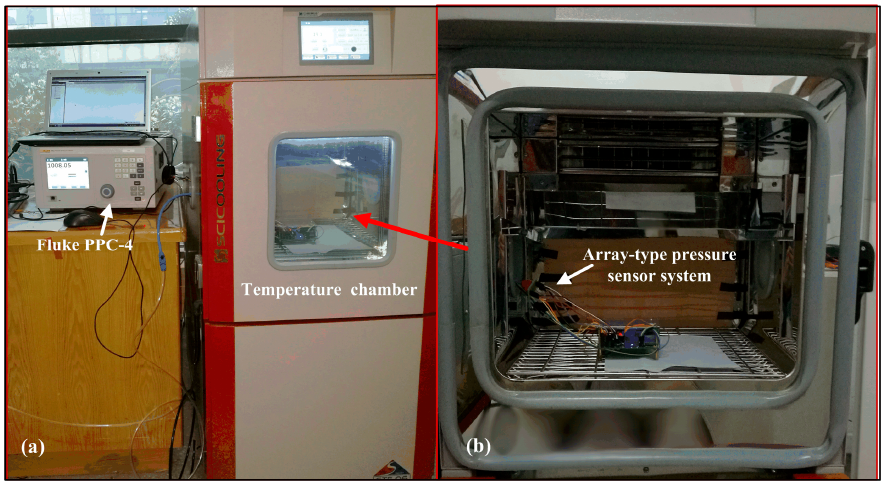
Figure 15. Photographs of calibration and test platform for the array-type pressure sensor